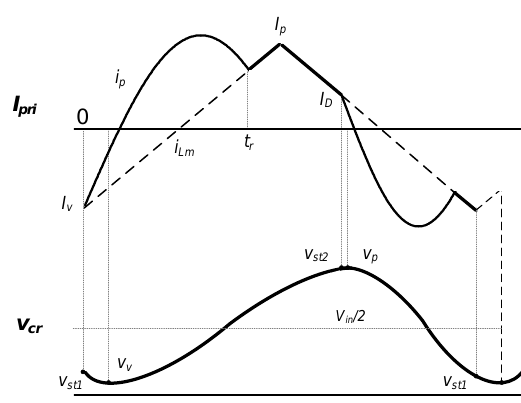
Figure 6. Waveforms of resonant current i pri ( t ) and voltage v CR ( t ) for steady state. Here n 1 = N s1 / N p and n 2 = N s2 / N p ,